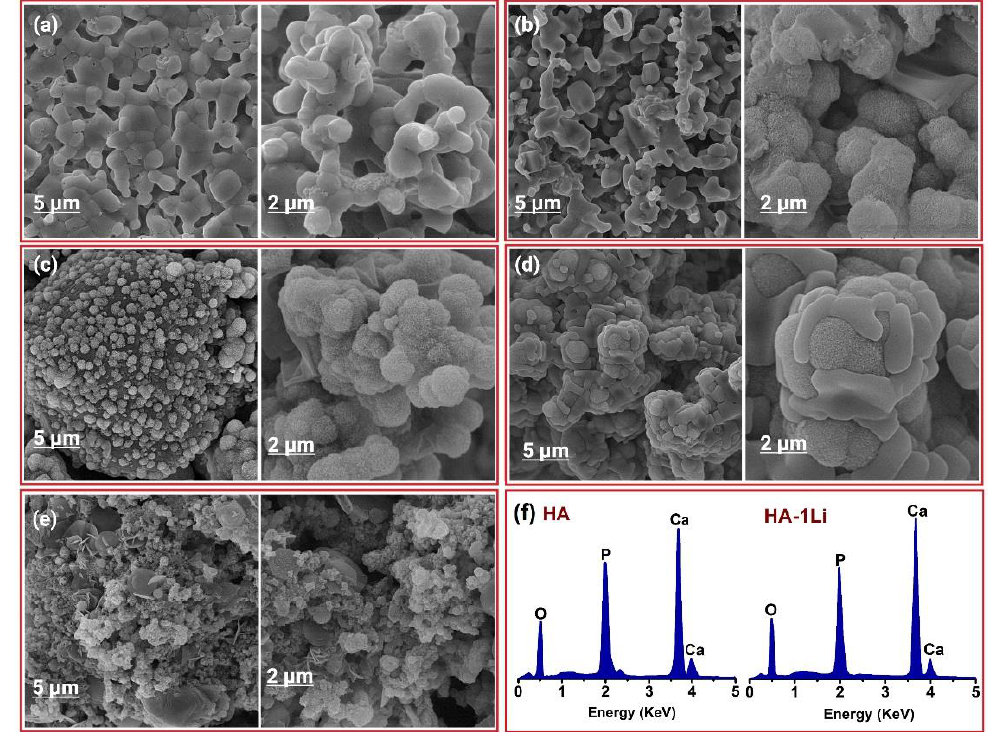
Figure 5. SEM micrograph of: ( a ) HA. ( b ) HA-0.5Li. ( c ) HA-1Li. ( d ) HA-2Li. ( e ) HA-4Li after soaking in SBF for 7 days and ( f ) the EDS of HA and HA-1Li.